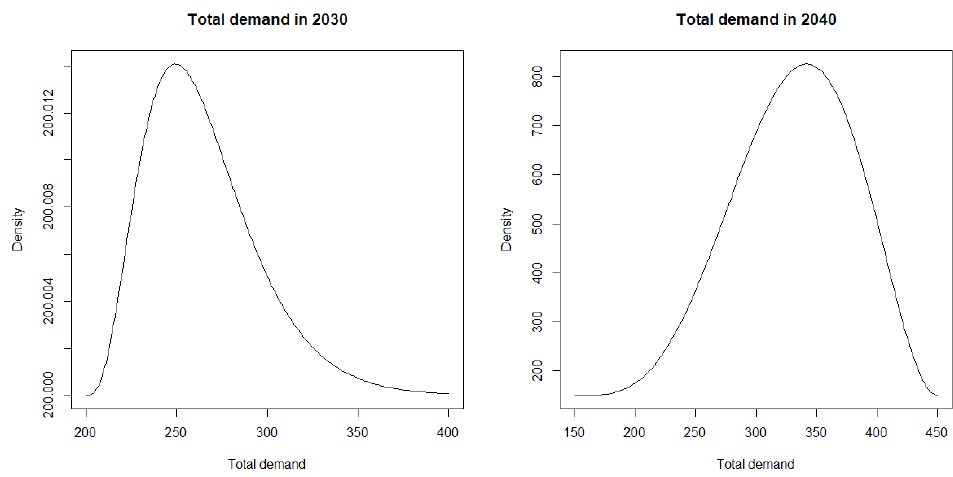
Figure 5. Probability density functions for total electricity demand in 2030 and 2040.